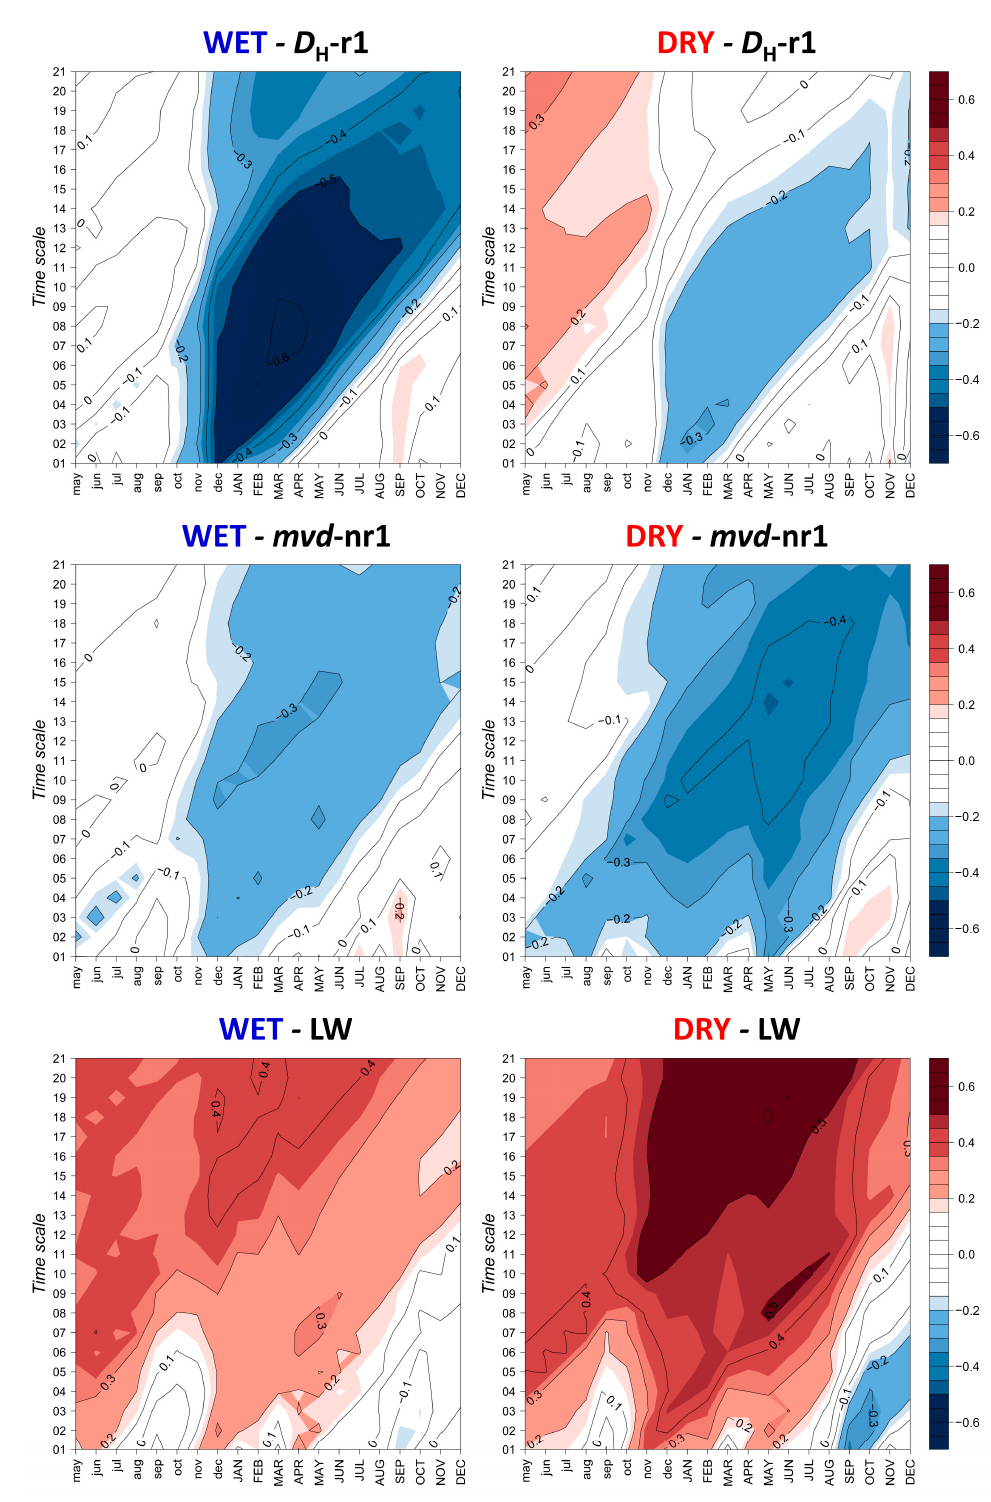
Figure 4. Correlations between monthly values of the standardized precipitation-evaporation index (SPEI) at different time scales (1–21) for the earlywood ( D H -r1 and mvd- nr1) and latewood (LW) chronologies for the period 1956–2013 (58 years). D H -r1: hydraulically weighted diameter of the first row; mvd- nr1: mean vessel diameter of vessels not belonging to the first row; LW: latewood width. Lower and uppercase letters correspond to the months of the previous and current growth years, respectively.